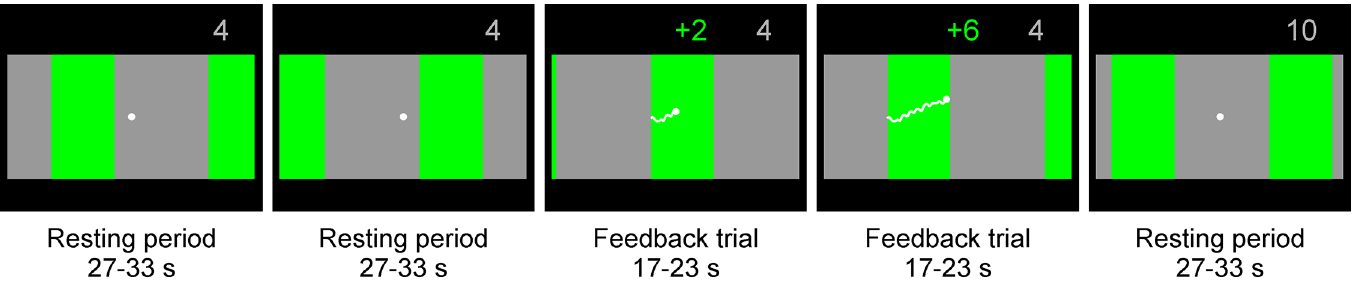
Fig 1. Feedback screen. On the background of the feedback screen, either green or gray stripes moved from the right to the left side of the screen with a constant speed. During the resting period, the white dot in the middle of the screen overlapped a gray stripe of the moving background and was vertically fixed in the center of the screen (first, second and fifth example screens in the figure). During the feedback trials, the white dot overlapped a green stripe of the moving background and participants tried to move the white dot up by motor imagery of swallowing (third and fourth example screens in the figure). When they were successful, the number of reward points increased (green reward points indicated number of reward points obtained in the actual feedback trial, gray reward points indicated sum of all obtained reward points of all previous feedback